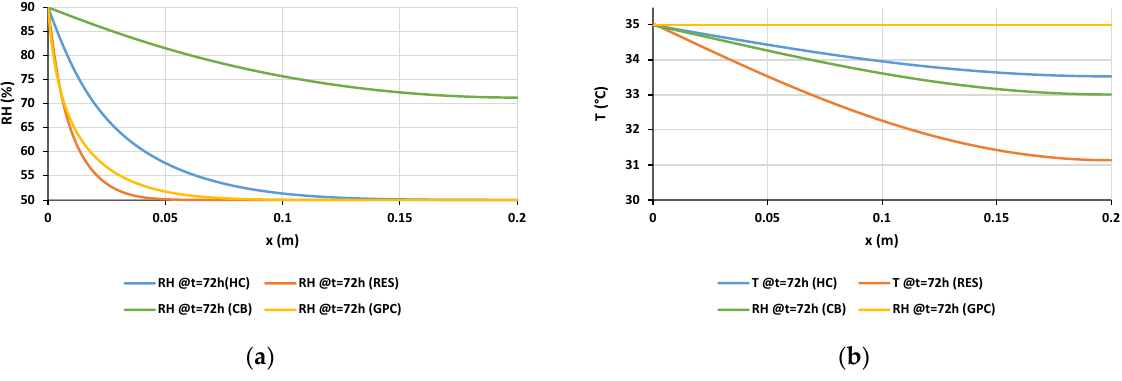
Figure 20. Relative humidity ( a ) and temperature profiles ( b ) inside the materials (hemp concrete, cob, and GPC) after 72 h.